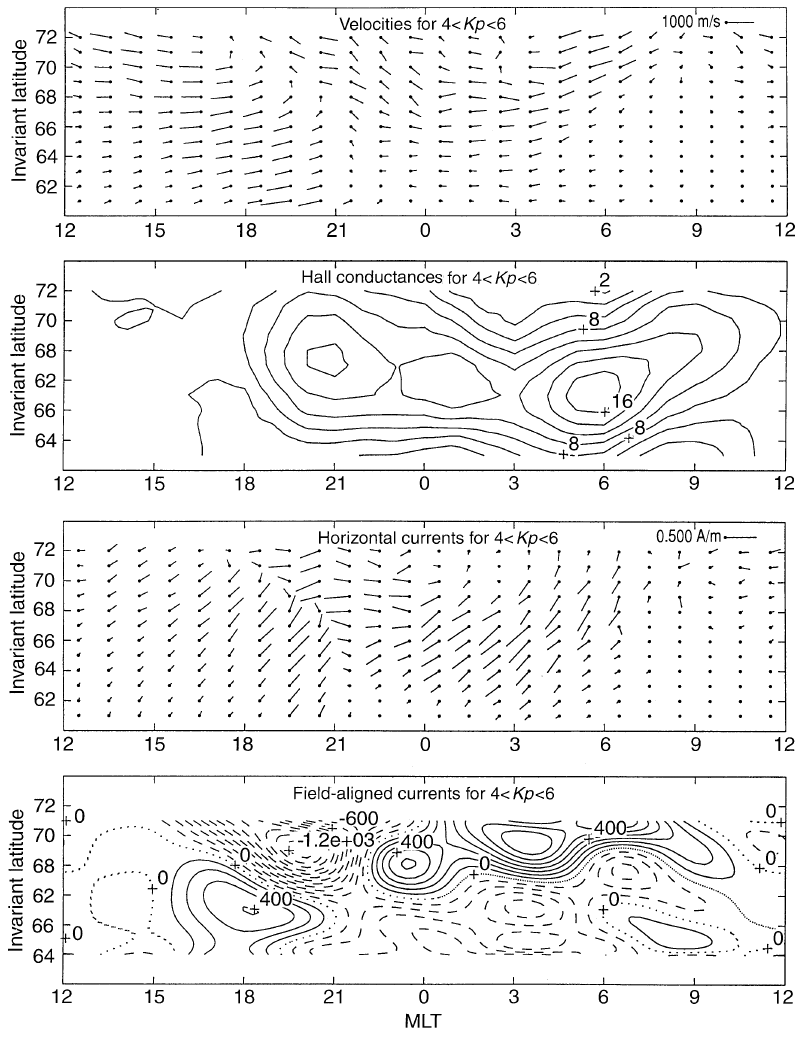
Fig. 7. Same as Fig. 6 for Kp " 4 —